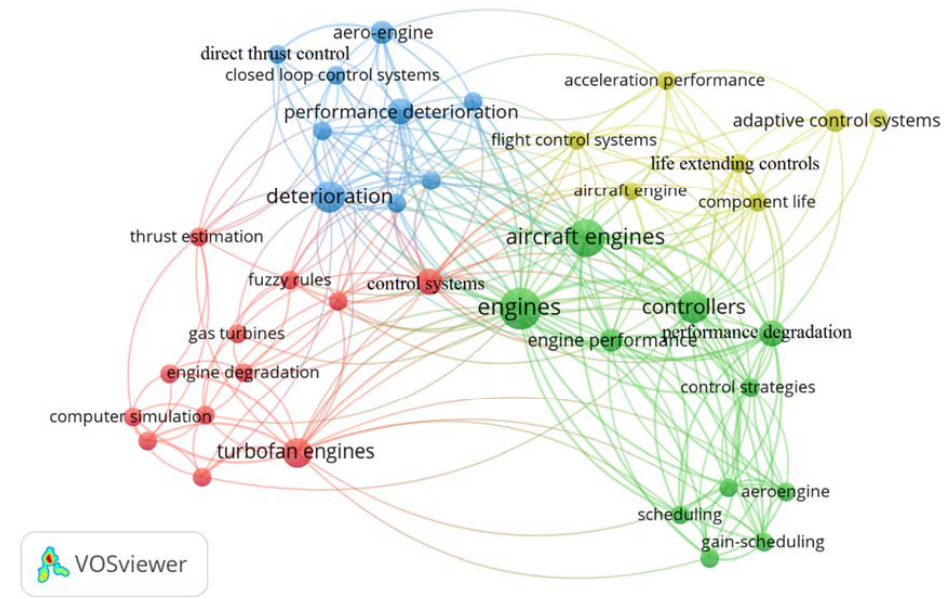
Figure 6. The co-occurrence network of words for Section 2. Figure 6. The co ‐ occurrence network of words for Section 2. Figure 6. The co ‐ occurrence network of words for Section 2.